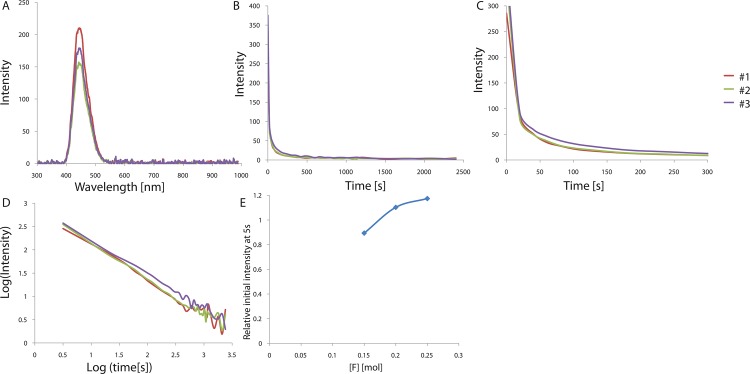
(A) Emission spectrum of CaAl2O4:Eu2+, Nd3+ crystals curves depending on H3BO3 concentration. (B) Decay curves depending on H3BO3 concentration. (C) Magnified views of the graph in (B). (D) Decay curves in log scale depending on H3BO3 concentration. (E) Relative initial intensity measured at 5s (relative values where the value of control sample #1 is 1.0) depending on H3BO3 concentration.